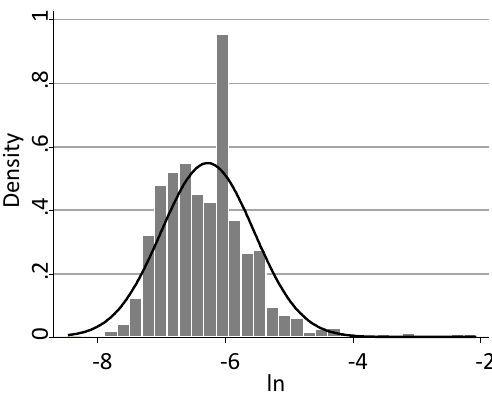
Figure 2. Histogram of natural logarithm of